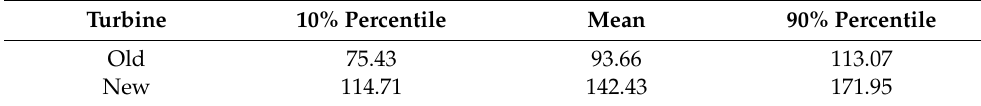
Table 10 sums up the five alternatives with their corresponding parameters.